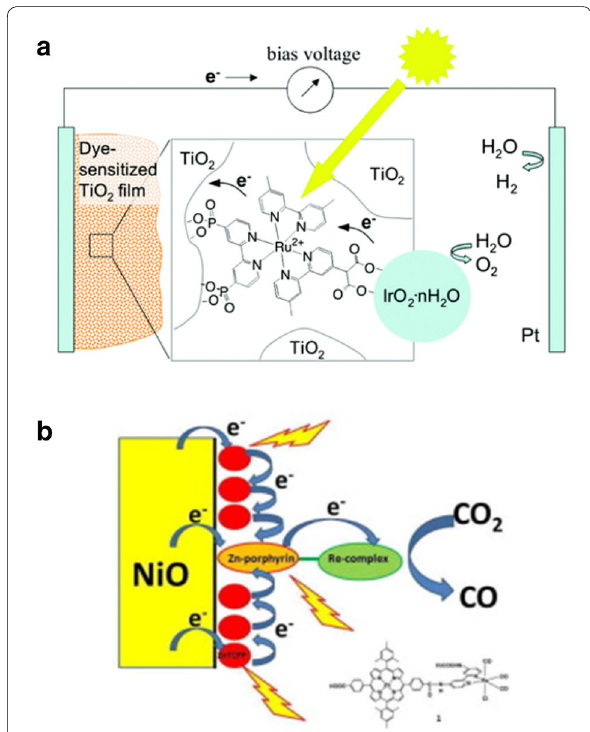
Fig. 7 DS-PEC cells with a a dye-sensitized photoanode for water splitting and b a dye-sensitized photocathode for CO 2